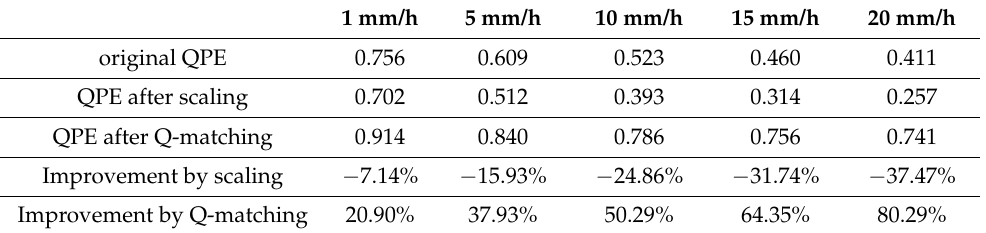
Table 2. The results of POD scores for 1 mm/h, 5 mm/h, 10 mm/h, 15 mm/h, and 20 mm/h thresholds of hourly radar QPE products compared to AWS rain observations. The improvement percentages are also given after correction methods by means of scaling and Q-matching.